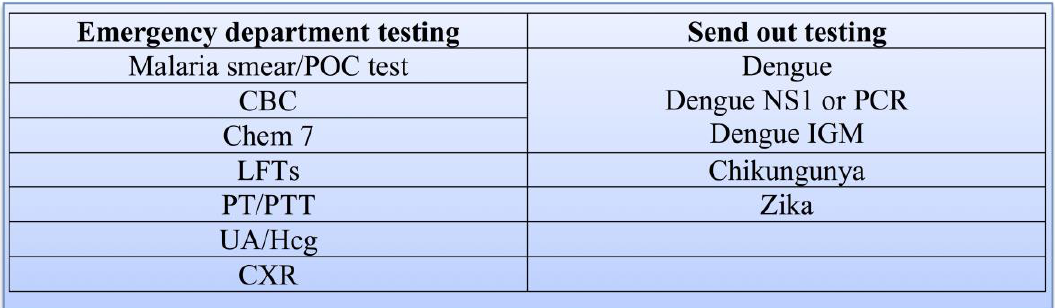
Figure 7. Proposed testing algorithm for the initial evaluation of a patient with suspected arbovirus infection. Depending on the region of travel, malaria and other native pathogens such as typhoid and leptospirosis also should be considered. POC , point of care; CBC , complete blood count; LFT s, liver function tests, PT/PTT , prothrombin time/partial thromboplastin time; UA/ Hcg , urinalysis/human chorionic gonadotropin, CXR , chest x-ray; PCR , polymerase chain